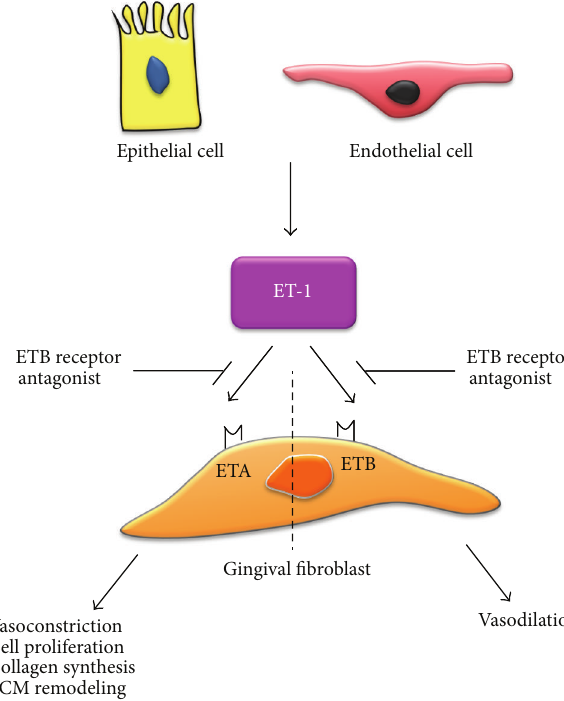
Figure 3: Potential role of endothelin-1 and its receptors expressed byfibroblastingingivalfibrosis.ET-1:endothelin-1;ETA:endothelin receptor A; ETB: endothelin receptor B; ECM: extracellular